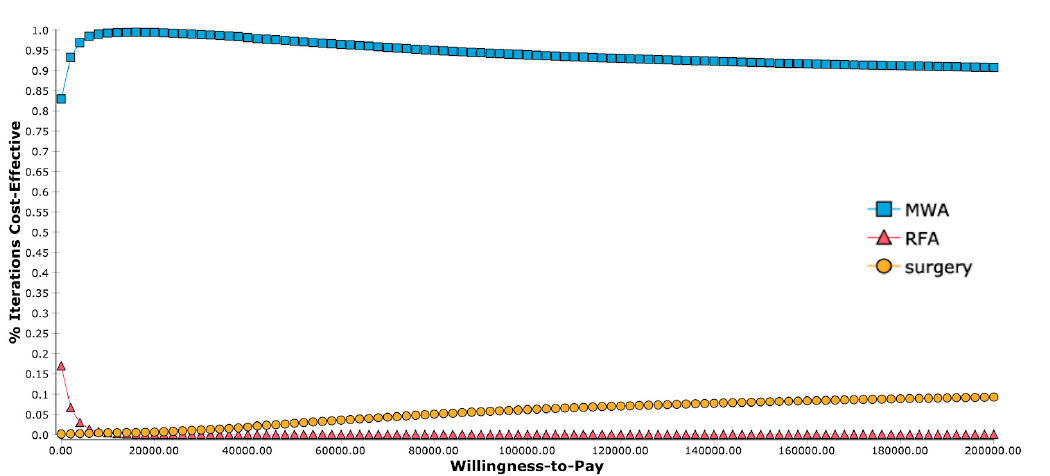
Figure 3. Acceptability curves for willingness-to-pay levels. In the range investigated, MWA is the cost-effective strategy in the majority of iterations.